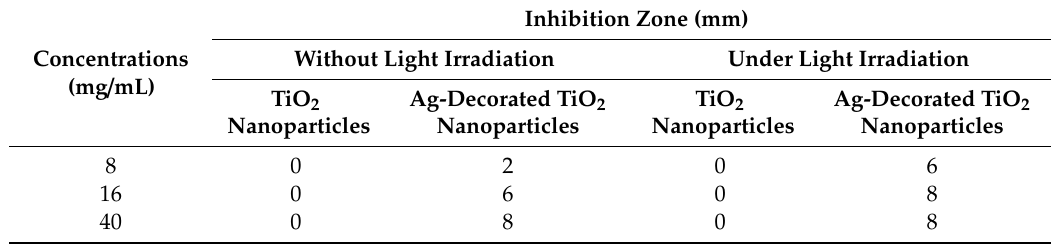
Table 2. Antibacterial activity against E. coli bacteria of TiO 2 nanoparticles and Ag-loaded TiO 2